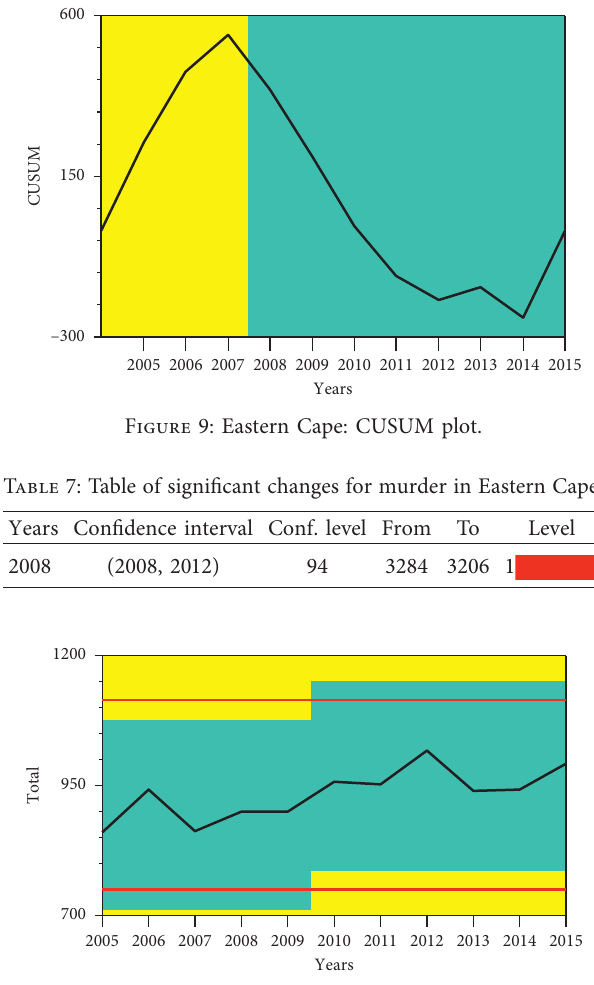
Figure 10: Free State: background changes.